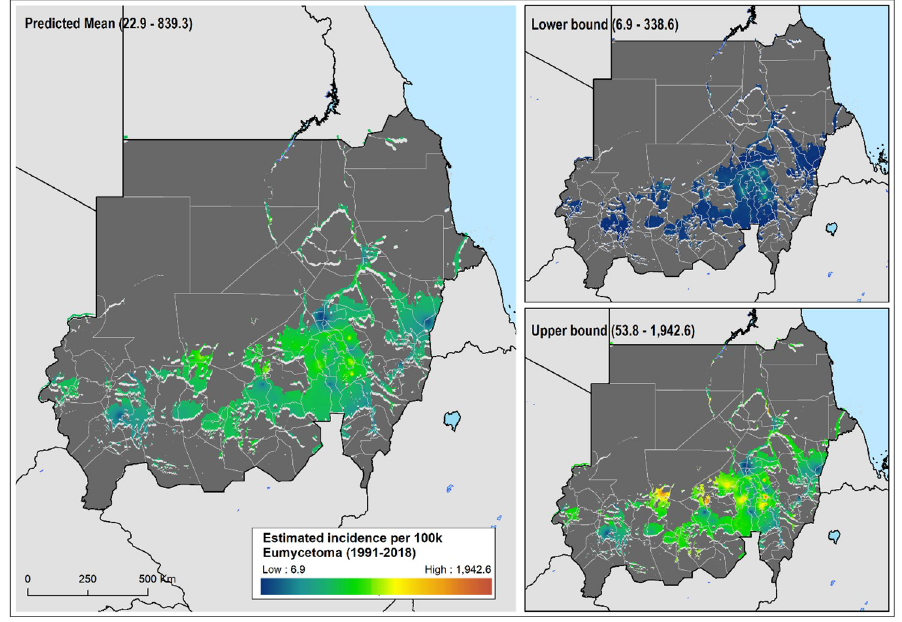
Fig 2. Estimated eumycetoma cases per 100,000 inhabitants between 1991 and 2018; mean predicted number of cases and, lower and upper 95% CI bounds. Areas considered environmentally unsuitable for the occurrence of eumycetoma as predicted by environmental model have been